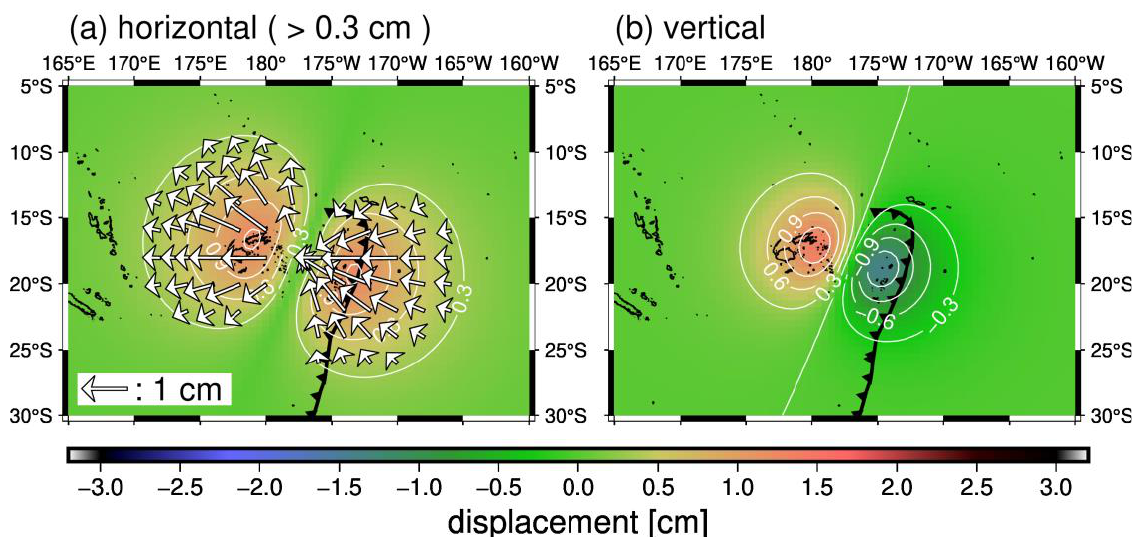
Figure 4. Calculation results of the coseismic surface crustal deformation. ( a ) Horizontal displace- ments. The length and direction of the arrows represent the displacements, respectively. The arrows are shown only for displacements of 0.3 cm or more for every 5 degrees of longitude and latitude. The colors also indicate the amounts of the displacements (the lengths of the arrows). The contour intervals are 0.3 cm. ( b ) Vertical displacements. The positive and negative values indicate uplift and subsidence, respectively. The contour intervals are 0.3 cm.